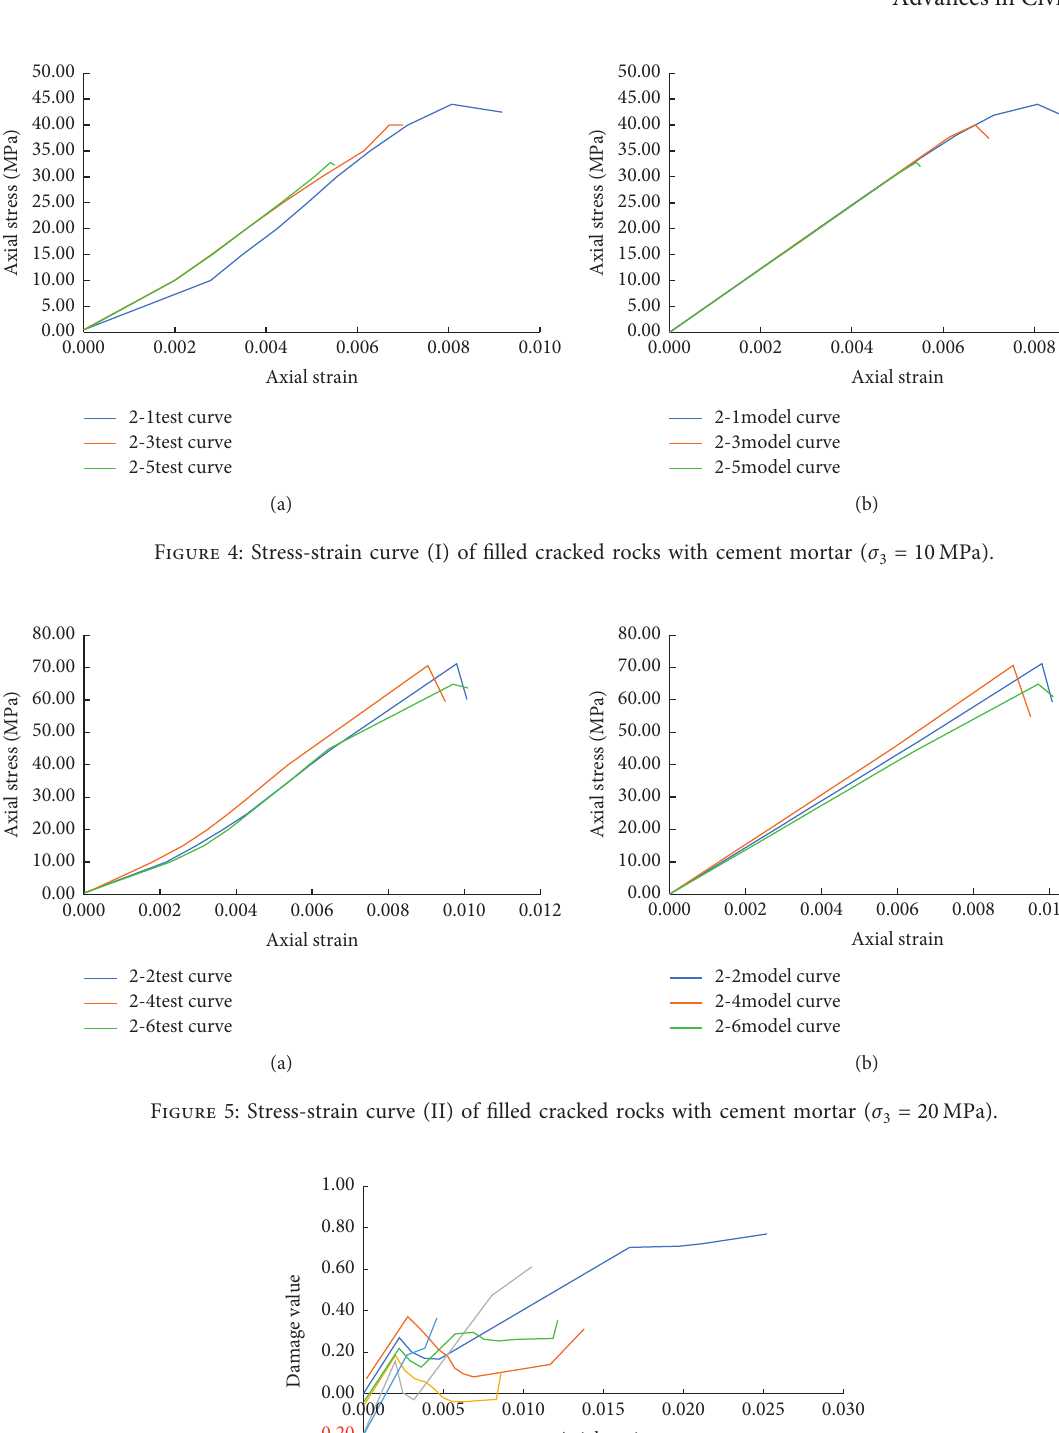
Figure 6: D − ε test curve of filled cracked rocks with gypsum 1 t damage occurs, with the increase of the confining pressure, Figure 9, the damage theoretical curve is zero in the com- the initial strain of the rock increases. It shows that the paction stage. From the beginning of plastic deformation, confining pressure hardening effect is significant. the damage begins to accumulate rapidly. When the initial